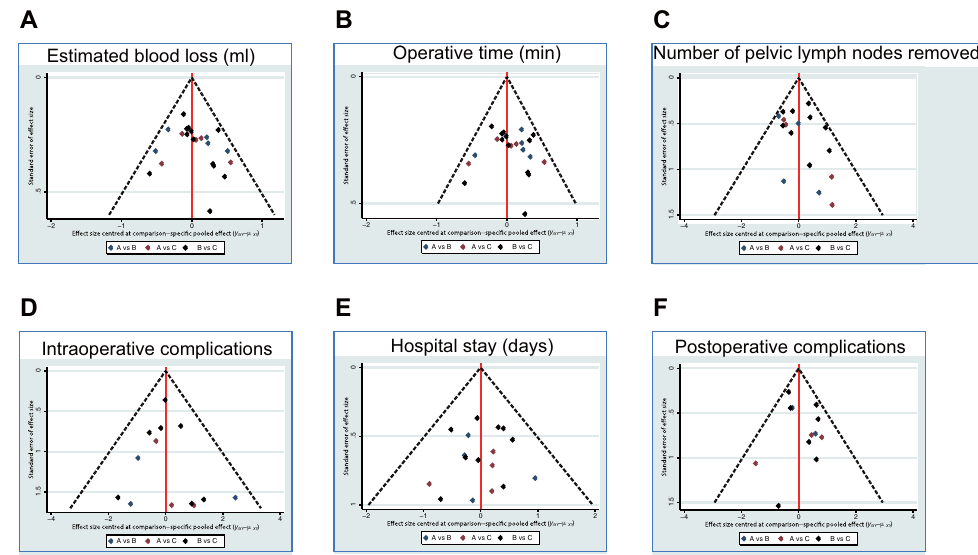
Fig 5. Funnel plot of estimated blood loss (ml), operative time (min), number of pelvic lymph nodes removed, intraoperative complications, hospital stay (days) and postoperative complications of RRH, LRH and ORH in the treatment of early-stage CC. Note: A = RRH (robotic radical hysterectomy); B = LRH (laparoscopic radical hysterectomy); C = ORH (open radical hysterectomy).